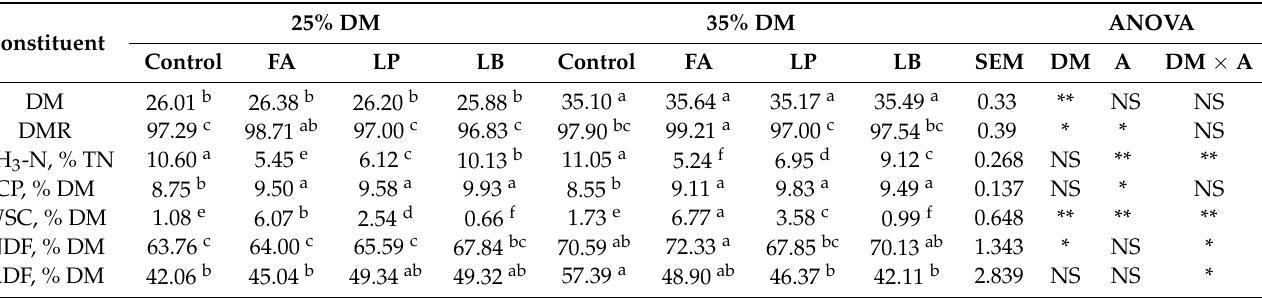
Table 3. Chemical composition of Italian ryegrass ensiled for 60